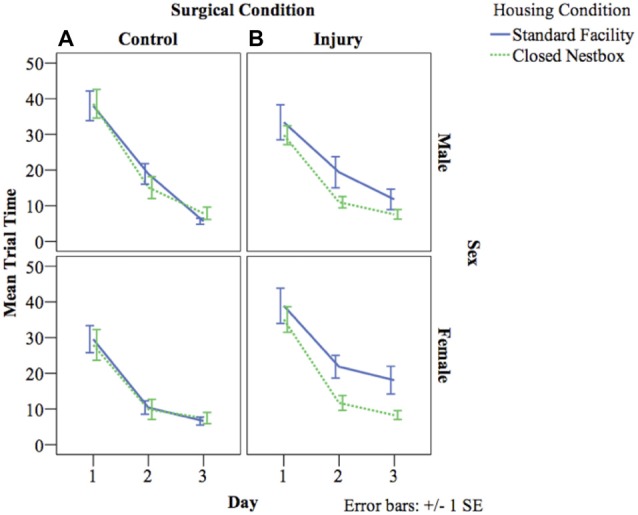
(A,B) Mean latency by study condition in visible platform (VP) training. The following graphs mark the average latency of animals to reach the platform over the course of the four water maze trials each day for three consecutive days. The lines compare average latency for animals in the CN and SF housing conditions according to surgical condition: (A) Control, (B) HI Injury. Only main effects were observed for latency for males (F(2) = 103.20, p < 0.05), and females (F(2) = 71.30, p < 0.05) with both demonstrating decreased latency across the three training days indicating successful task acquisition.